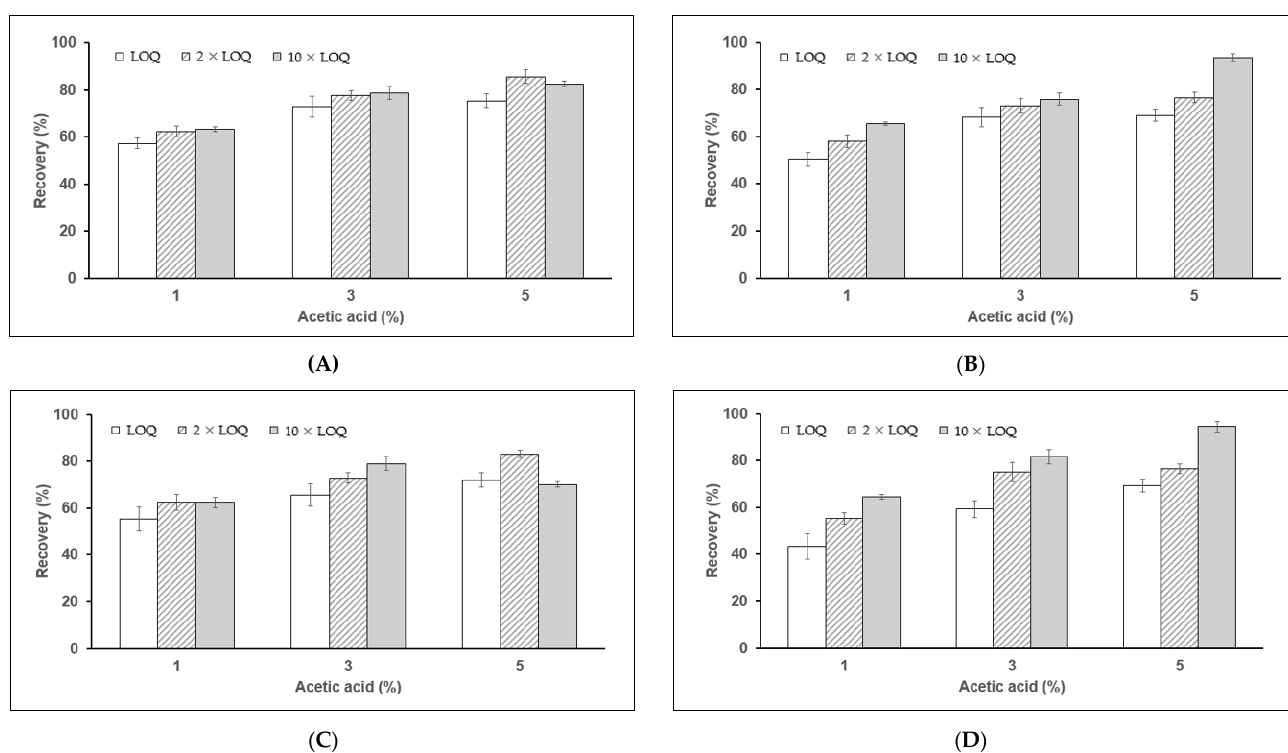
Figure 1. Effects of acetic acid concentration on the recoveries of fenpropimorph ( A , B ) and fenpropimorph acid ( C , D ) fortified in the milk ( A , C ) and egg ( B , D ) samples. Data are means ± SD of 5 replicates.